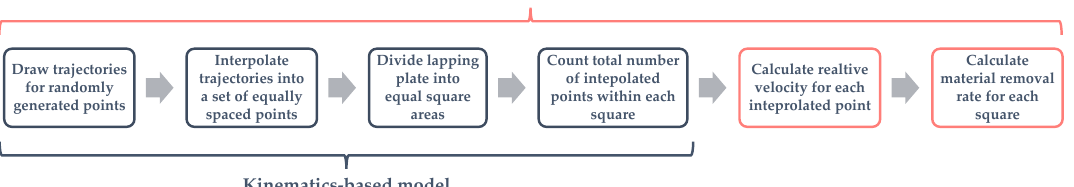
Figure 6. Kinematics and kinematics-mechanistic models comparation.